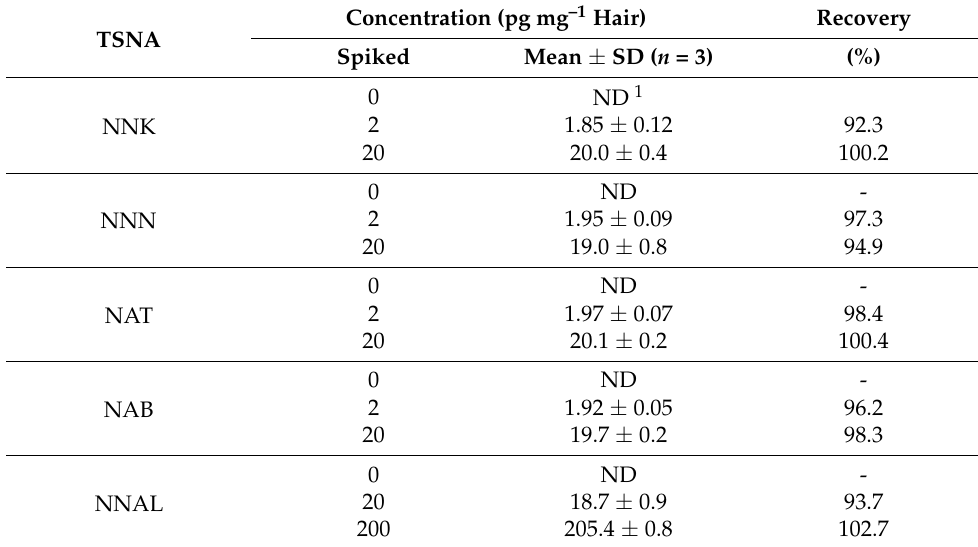
Table 3. Recoveries of TSNAs spiked into hair samples of a non-smoker.